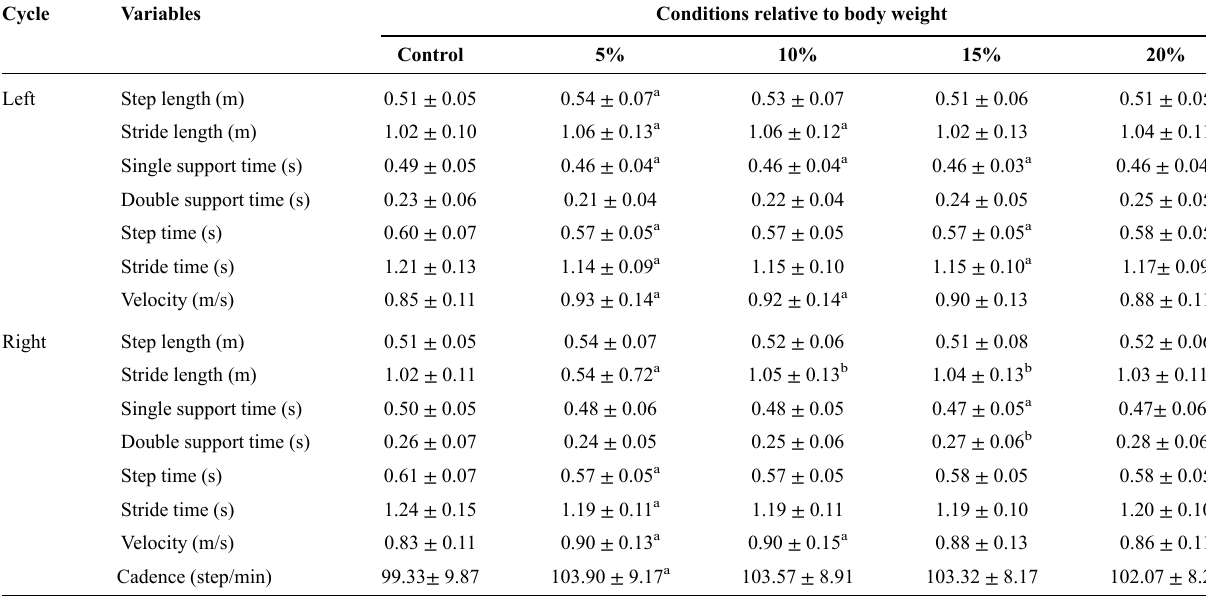
Note: a = different from control condition; b = different from 5% load condition; Repeated measures ANOVA comparisons with Bonferroni correction; Significance level (p ≤ 0.05).